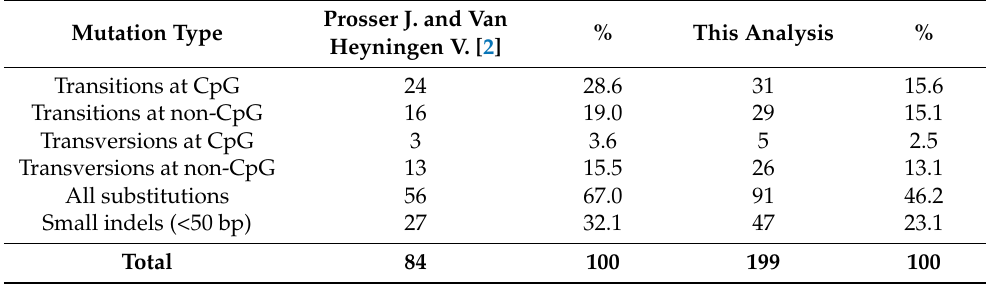
Table 4. Comparison of numbers of PAX6 substitutions in different contexts identified in two